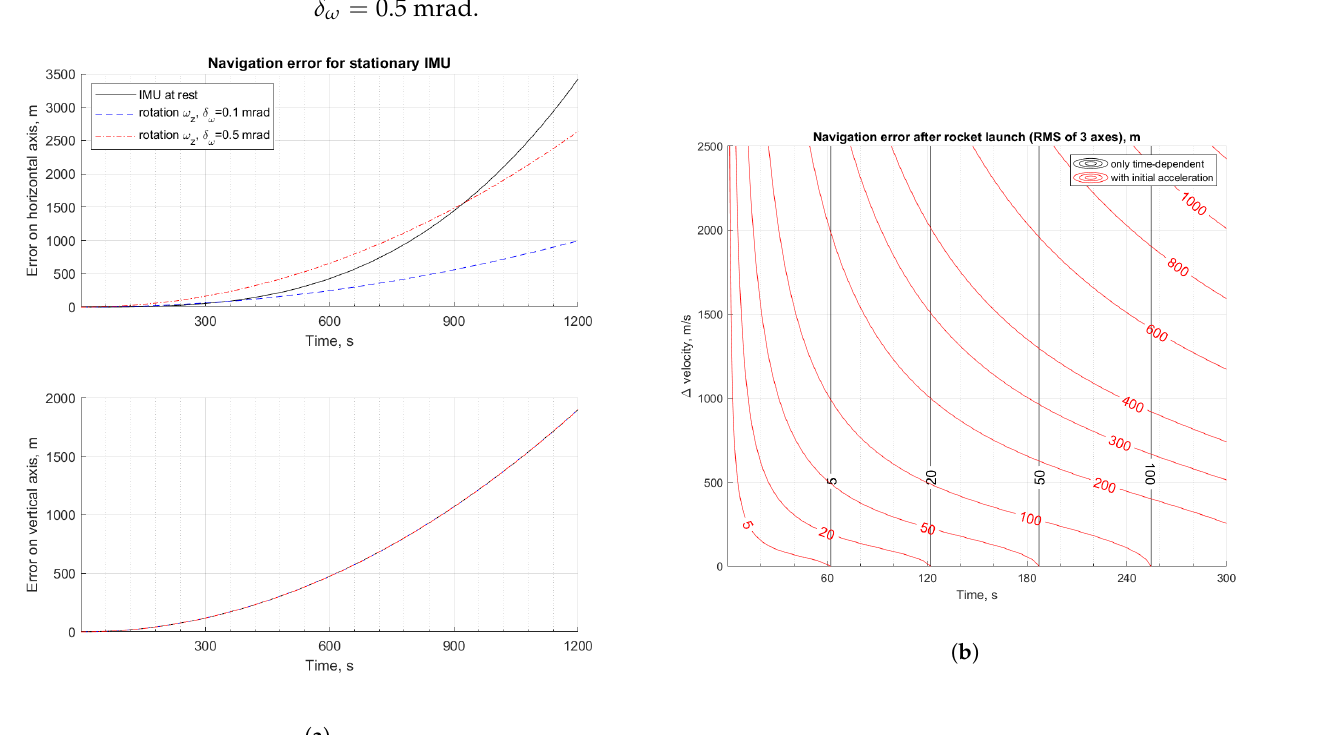
Figure 3. Influence of continuous rotation and launch acceleration on navigation system accuracy: ( a ) effect of stationary IMU rotation ω z around vertical axis on the navigation system error for two values of gyroscopes misalignment δ ω ; errors along horizontal and vertical axes, respectively, in top and bottom plot; ( b ) contour plot showing effect of constant acceleration during launch on rocket navigation system accuracy, depending on target flight velocity ∆ V and duration of the launch